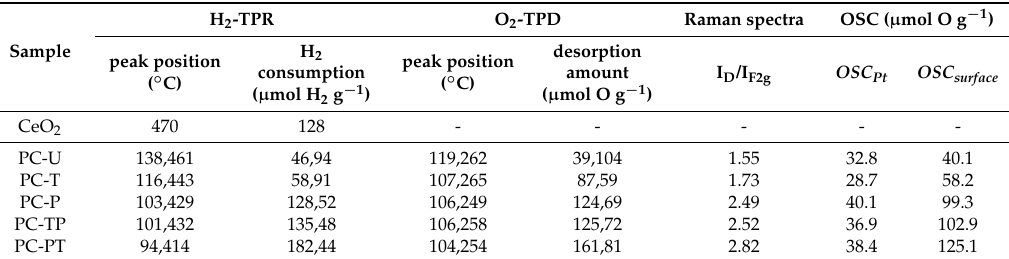
Figure 6. H 2 -TPR profiles of different Pt/CeO 2 samples. Table 4. H 2 -TPR, O 2 -TPD, Raman and OSC data of various samples.